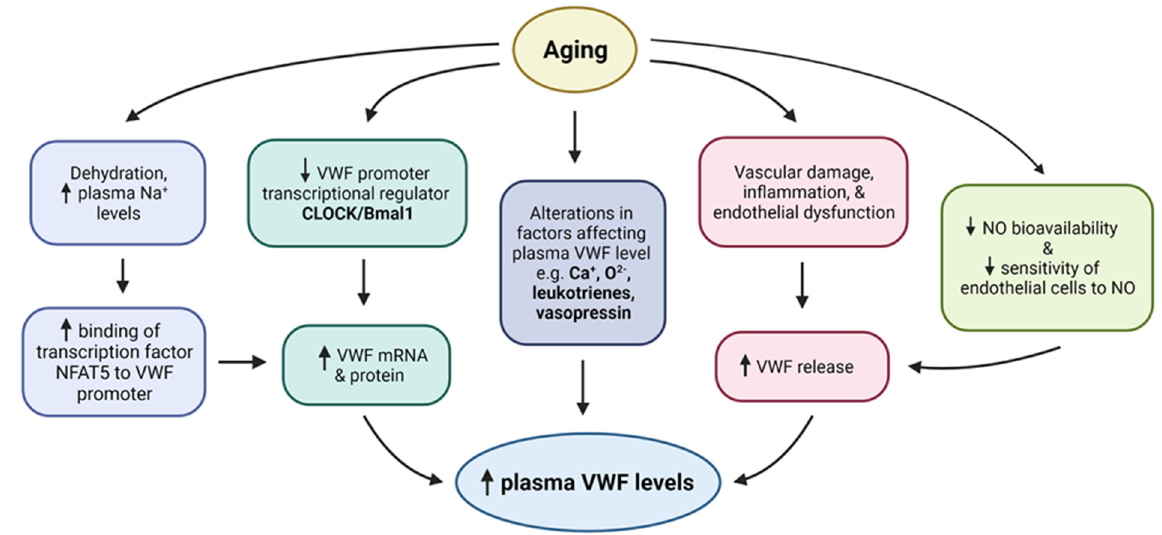
Figure 2. Potential mechanisms of age associated increase in VWF levels. Upward and downward arrows depict increase and decrease respectively.